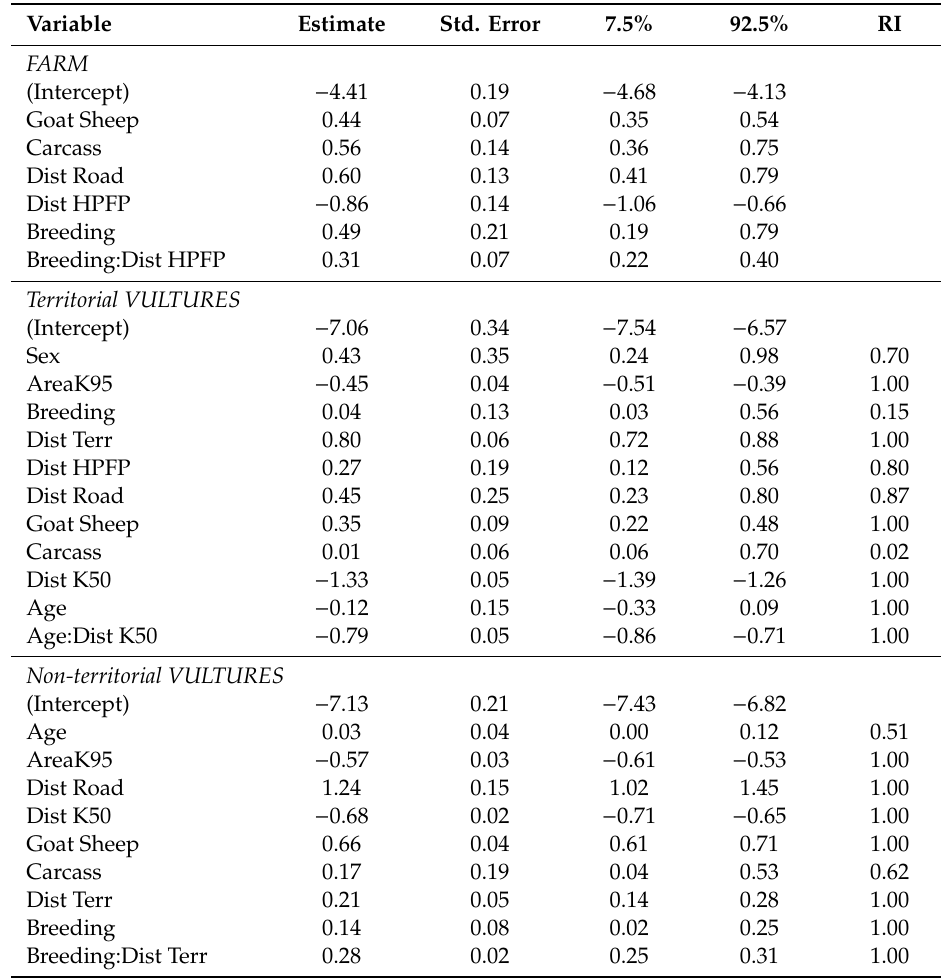
Table 4. Results of the best model for the response variables FARM and the full coe ffi cients of model average for territorial VULTURES and non-territorial VULTURES . The estimates shown are the original outcome. See Table 1 for a full description of explanatory variables; 85% confidence intervals of the estimates are shown (7.5% and 92.5% limits). The reference level for factor Breeding is non-breeding season and for factor Sex is